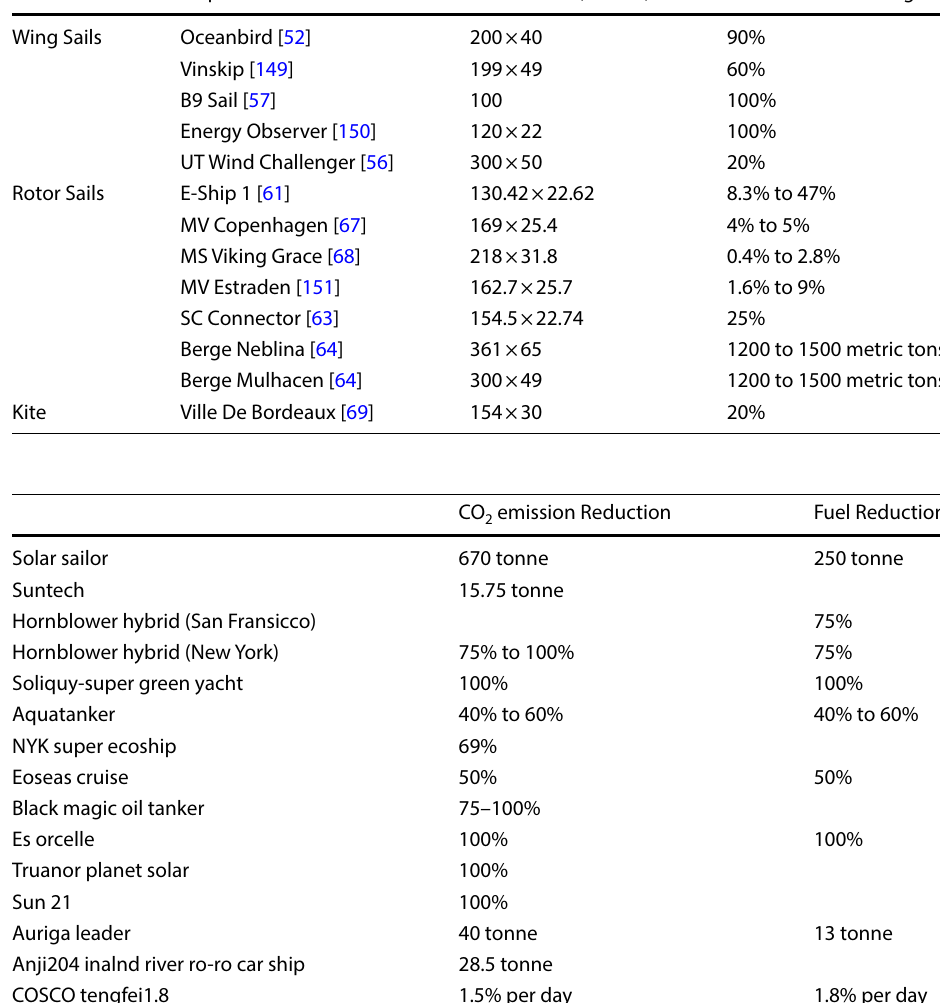
Table 2 Vessel size and estimated fuel savings for wind